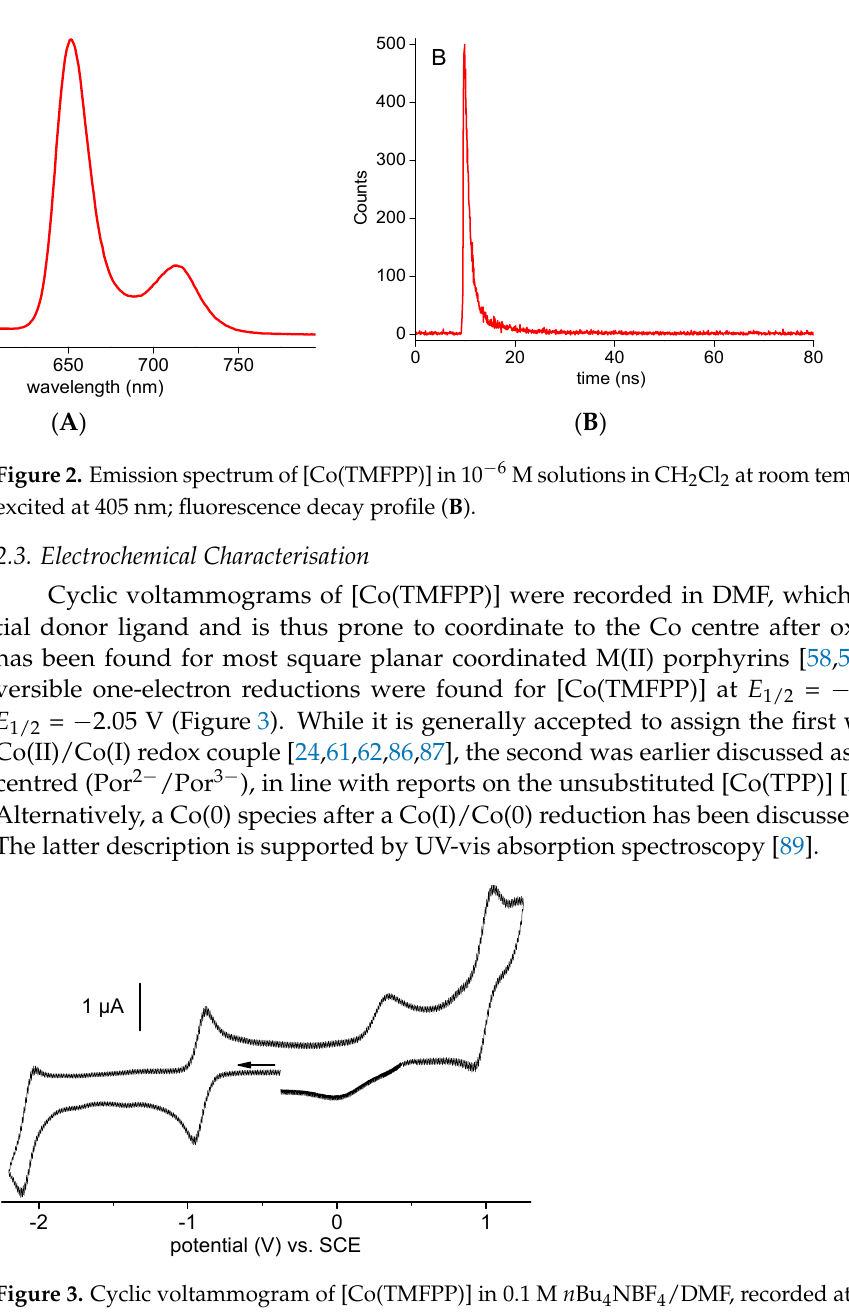
4 NBF 4 /DMF, recorded at 100 mV s